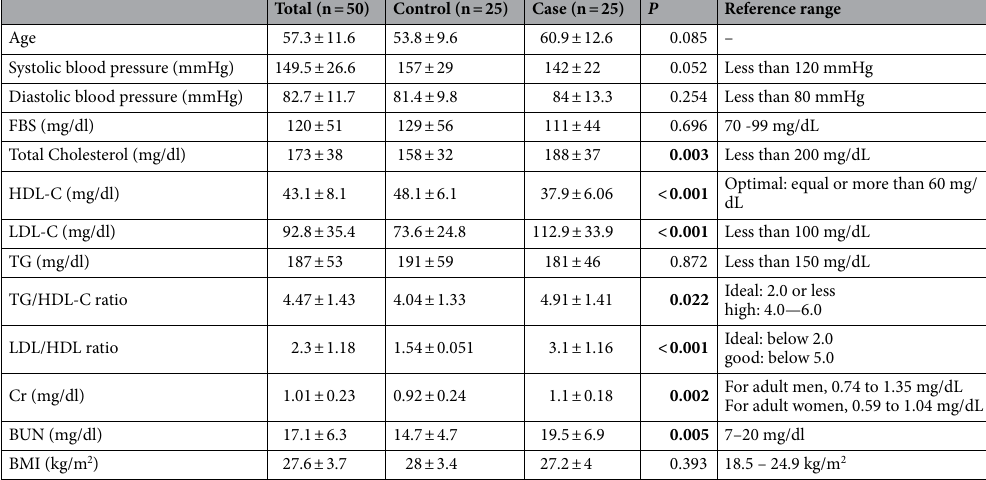
Table 1. Comparison of continuous variables between control and case groups. FBS fasting blood sugar, HDL-C high density lipoprotein-cholesterol, LDL-C low density lipoprotein-cholesterol, TG triglycerides, Cr